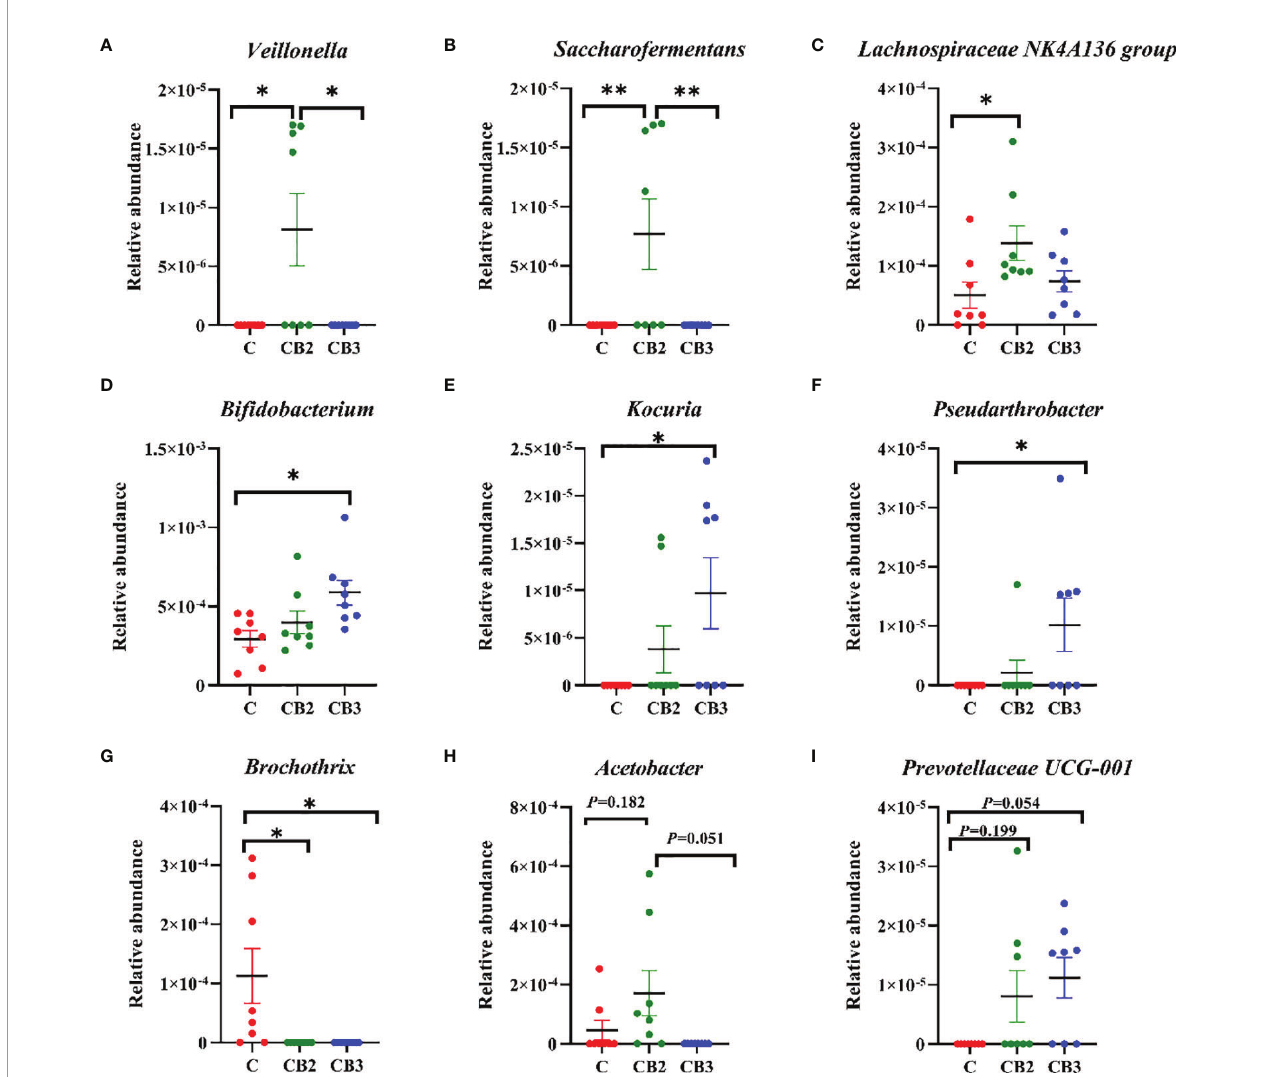
FIGURE 10 | Effects of dietary chitosan oligosaccharides (COS) and Clostridium butyricum synbiotic supplementation on the relative abundance of ileal microbiota at the genus level in early-weaned pigeon squabs. (A) Veillonella . (B) Saccharofermentans . (C) Lachnospiraceae NK4A136 group . (D) Bi fi dobacterium . (E) Kocuria . (F) Pseudarthrobacter . (G) Brochothrix . (H) Acetobacter . (I) Prevotellaceae UCG-001 . Values are means with the SEM of eight squabs. * p < 0.05 and ** p < 0.01. C group, control group, squabs fed with arti fi cial crop milk; CO group, squabs fed with arti fi cial crop milk + 150 mg/kg COS; CB2 and CB3 group, squabs fed